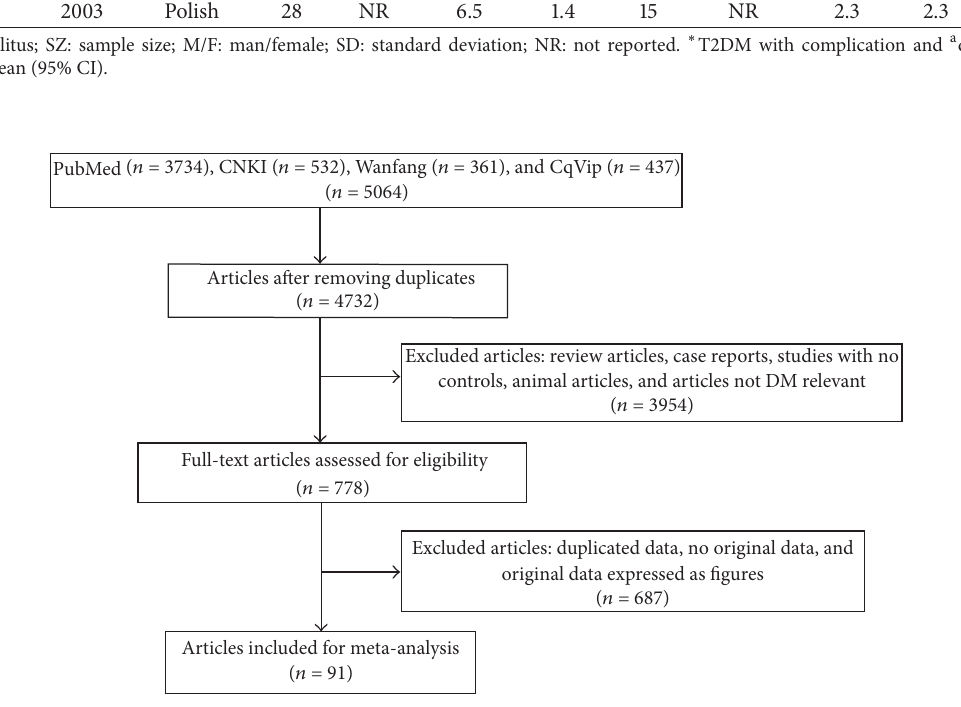
Figure 1: A flow chart of the article search and inclusion